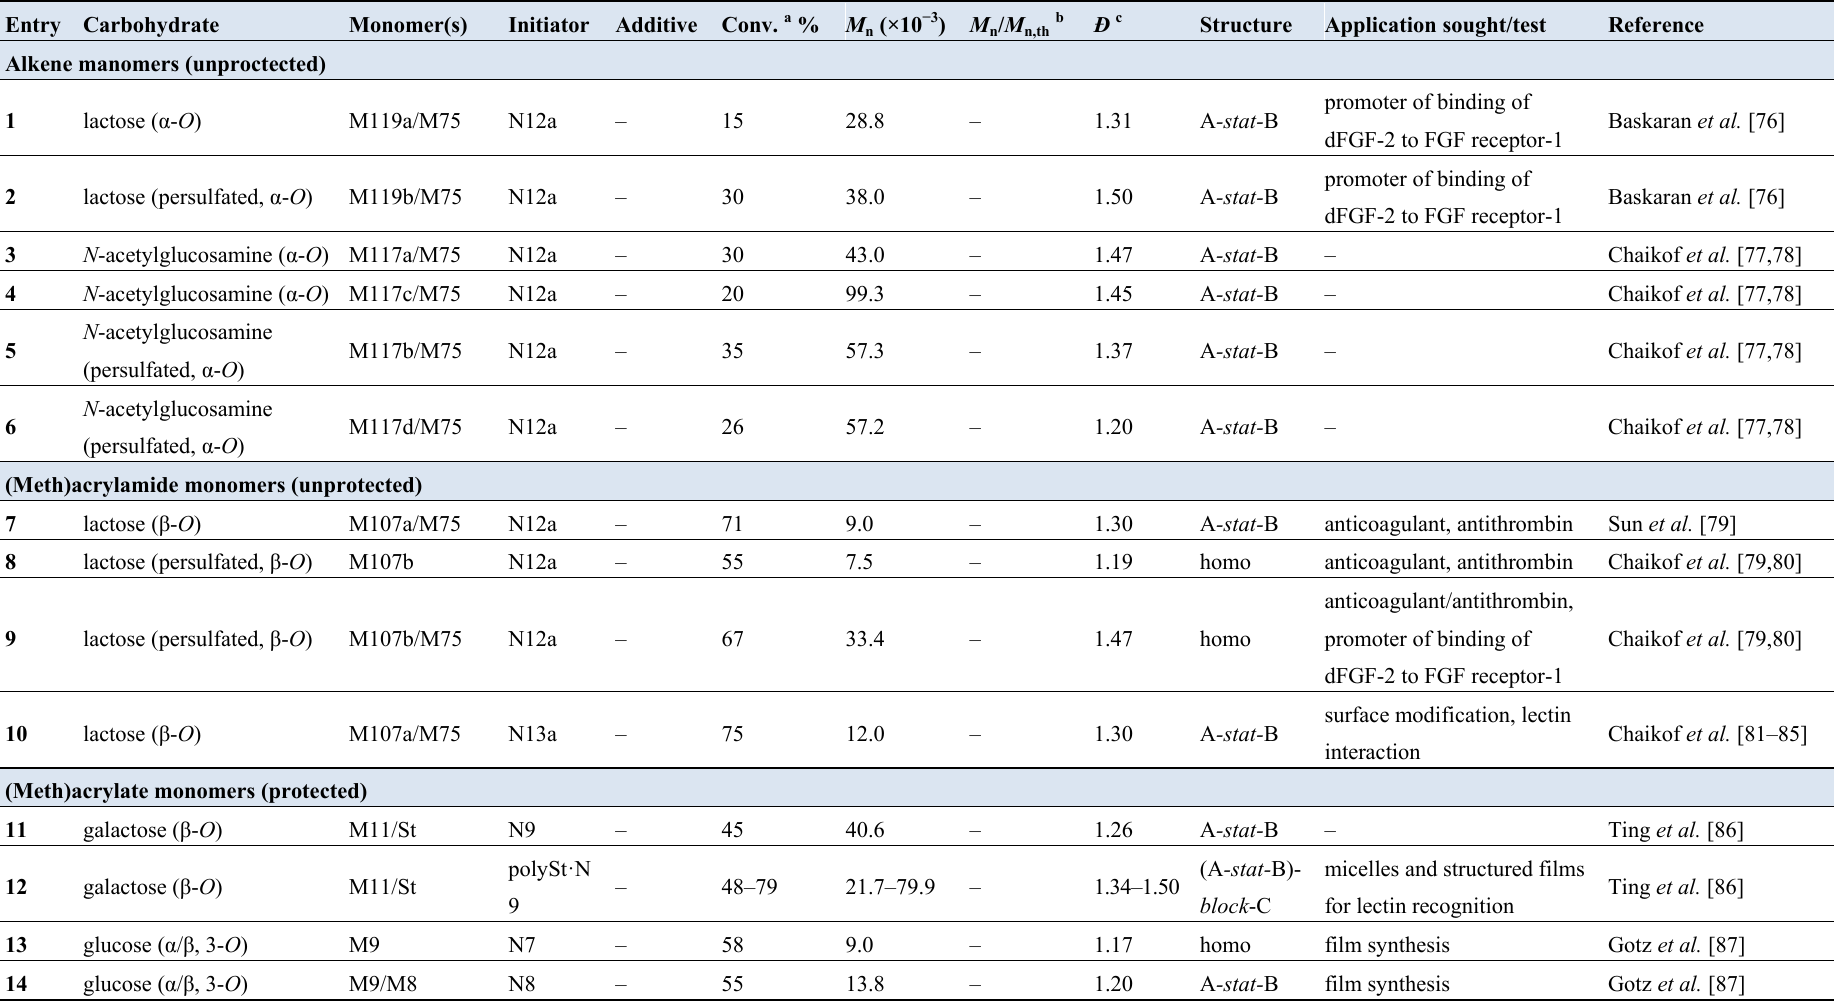
Table 1. Glycopolymers by Stable Free Radical Polymerization